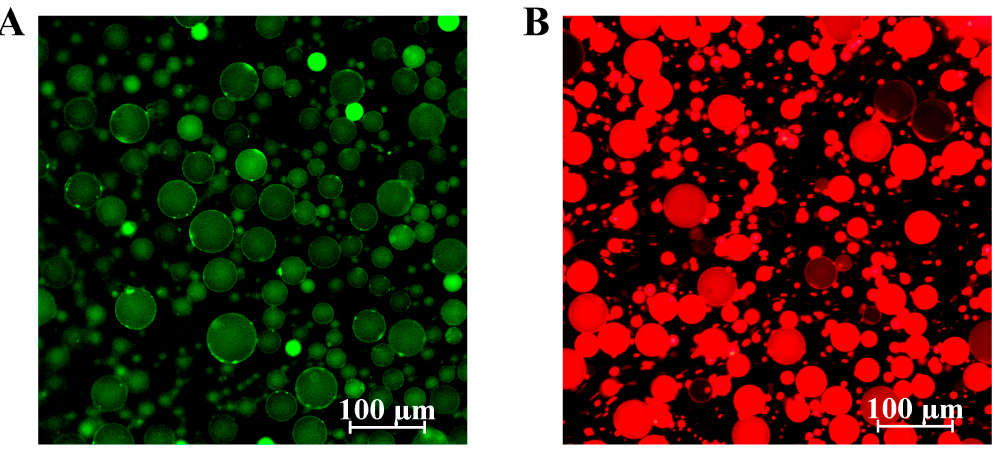
Figure 7. Fluorescence microscopic images of Pickering emulsions stabilized with LF–FD complexes: ( A ) the oil phase stained with Nile Red; ( B ) LF–FD complexes stained with Rhodamine B. The scale bars within the figures are 100 μ m in length.